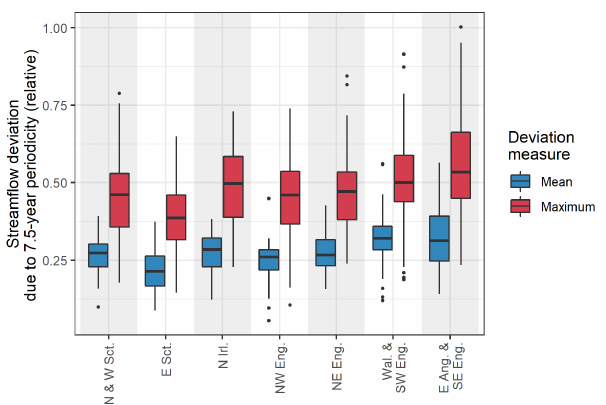
Figure 7. Modulation of summer streamflow (relative to record standard deviation) as a result of the principal cross-wavelet peri- odicity between the NAOI and winter